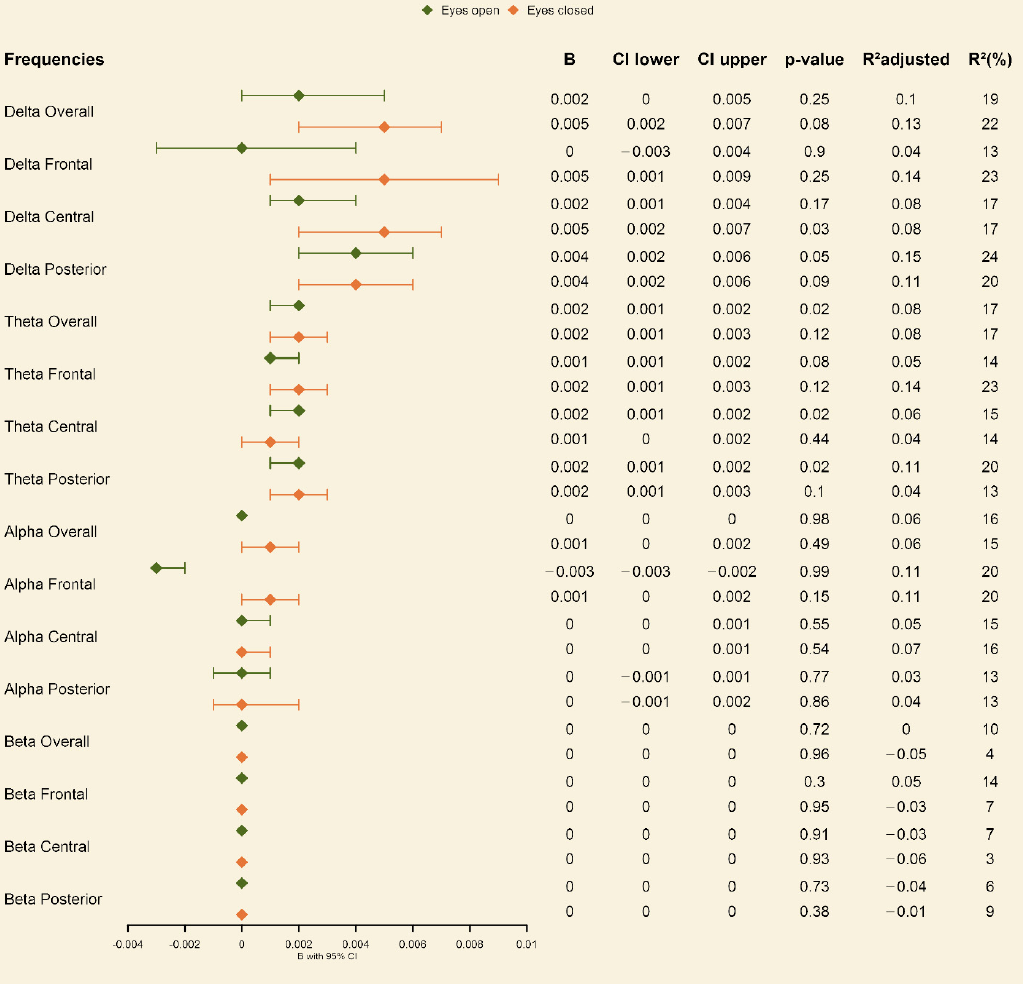
Figure 1. Forest plot showing the association between smoking during pregnancy and offspring EEG activity when comparing the exposed and non-exposed groups, adjusted for covariates (child’s sex, child’s age, maternal age, maternal psychopathology, maternal smoking before pregnancy, maternal alcohol drinking, week of pregnancy at birth).